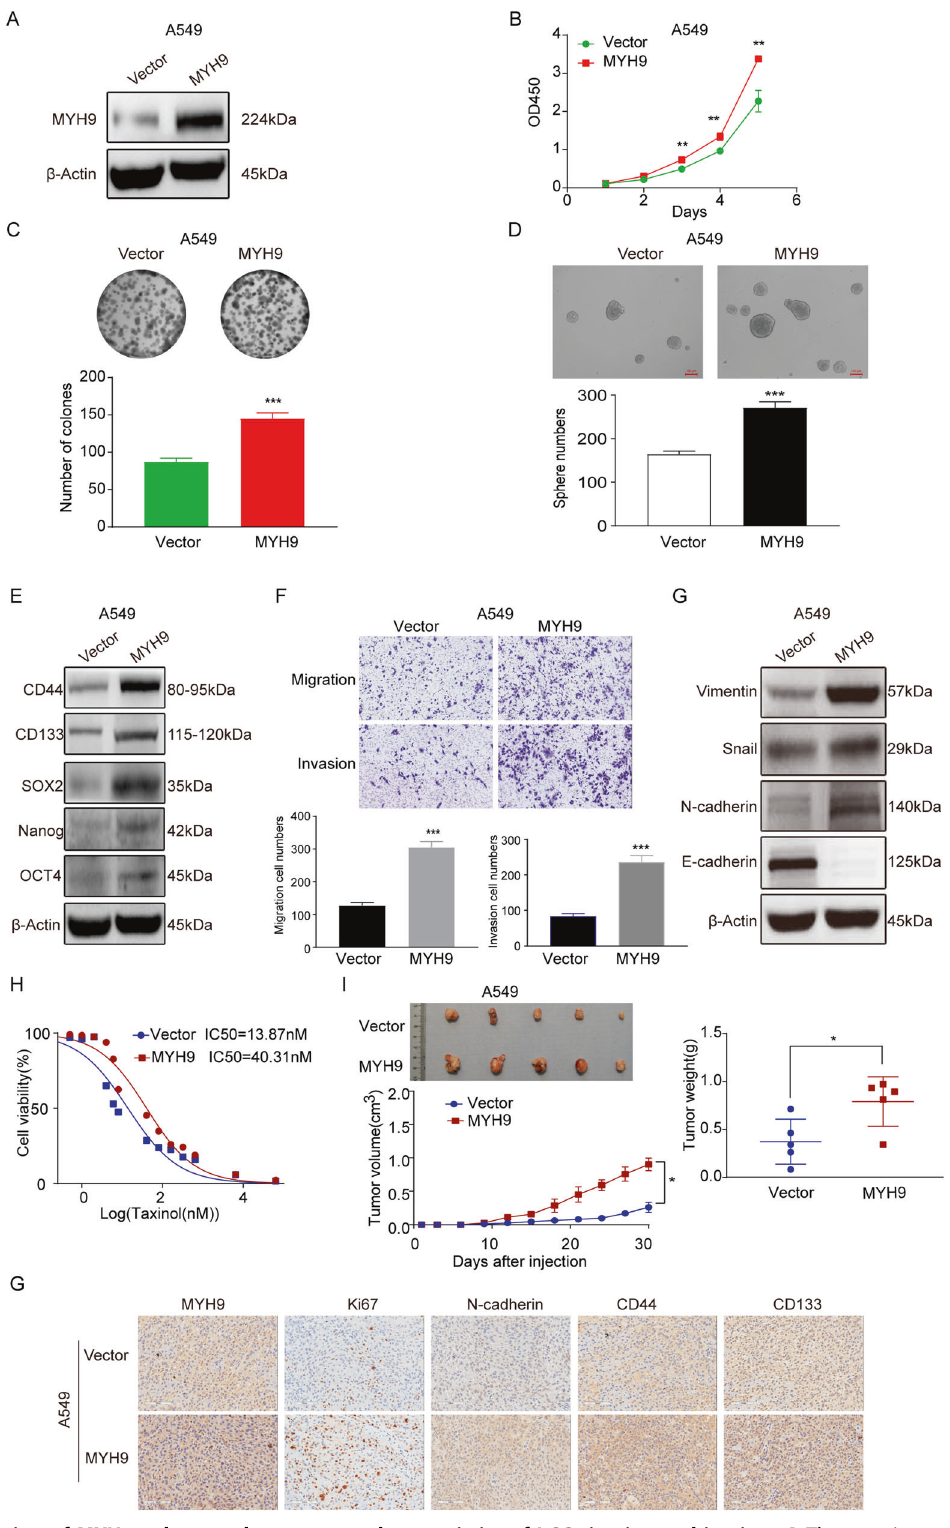
Fig. 3 Overexpression of MYH9 enhances the stemness characteristics of LCCs in vivo and in vitro. A The protein expression of MYH9 in A549-MYH9 and A549-Vector cells. B , C Proliferation ability of A549-MYH9 and A549-Vector cells (mean ±SD; n = 3; ** p <0.01 and *** p < 0.001; Student ’ s t -test). D Self-renewal ability of A549-MYH9 and A549-Vector cells (mean ± SD; n = 3; *** p <0.001; Student ’ s t -test). E The expression levels of CD44, SOX2, CD133, OCT4, and Nanog in MYH9 overexpressed and control cells. F Migration and invasion ability of A549-MYH9 and A549-Vector cells (scale bar, 200 μ m; mean ± SD; n = 3; *** p <0.001; Student ’ s t -test). G Expression of E-cadherin, Snail, Vimentin, and N-cadherinin A549-MYH9 and A549-Vector cells. H Analysis of drug resistance of MYH9-overexpressing and control cells to paclitaxel. I Growth of xenografts of A549 – MYH9 and A549-Vector cells in nude mice (mean ±SD; n = 5; * p <0.05 and ** p <0.01; Student ’ s t -test). J Analysis of the expression of MYH9, Ki67, N- cadherin, CD133, and CD44in transplanted tumor tissues of A549-MYH9 and A549-Vector cells (scale bar, 100 μ m; n = 5). Cell Death Discovery (2021)